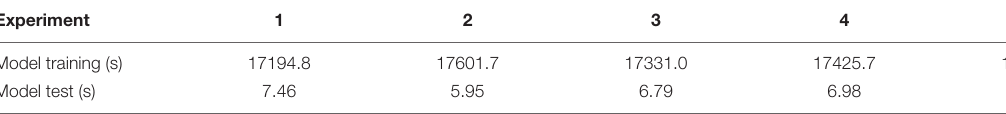
TABLE 8 | Running times in fivefold cross validation.